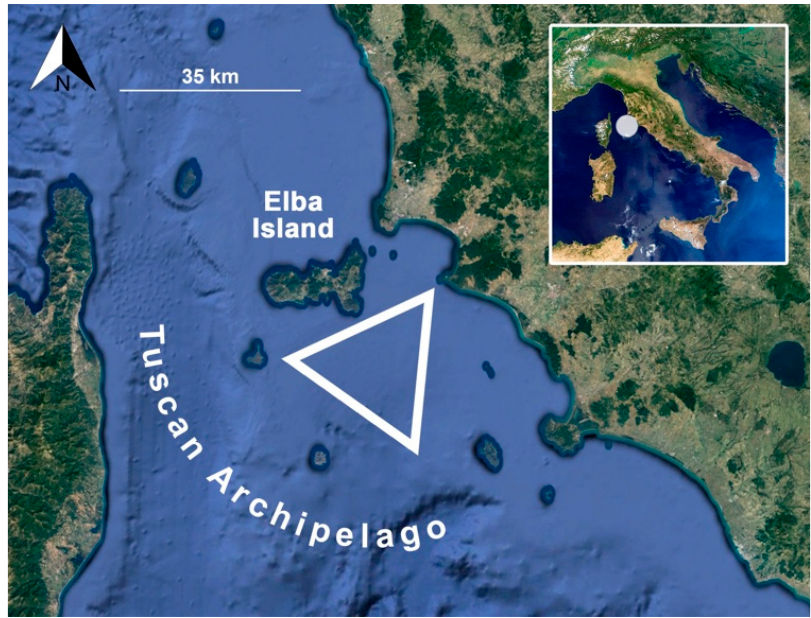
Figure 1. Localization of the sampling area. The white triangle indicates the fishing area of the samples